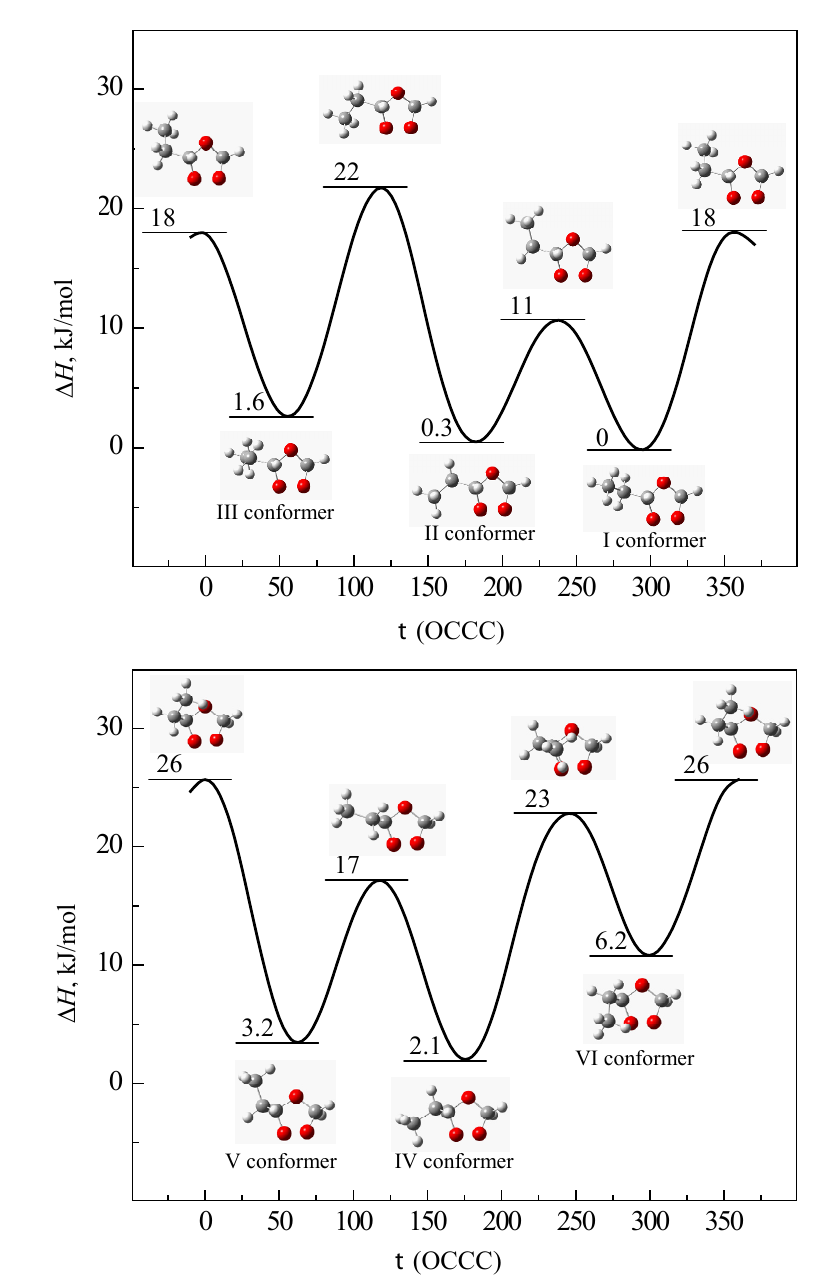
Figure 2. DFT calculated (B3LYP \6-311++G(3df, 3pd)) torsional (OCCC) potentials for equatorial (top) and axial (bottom) conformers.